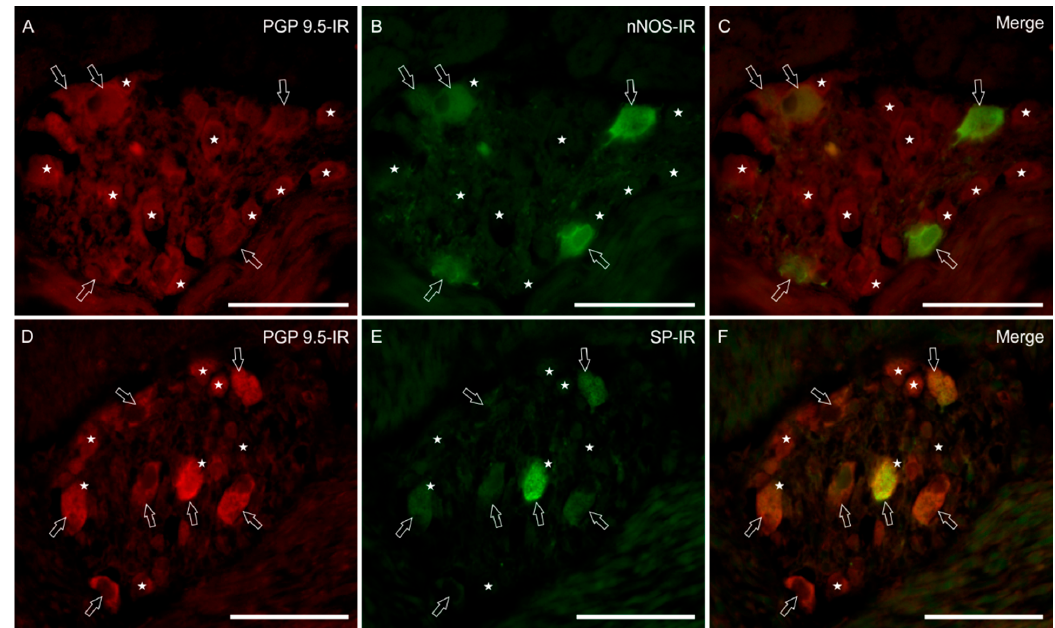
Figure 1. Micrographs showing nNOS ( A – C ) and SP immunoreactivity (IR) ( D – F ) in longitudinal sections of the myenteric plexus in bottlenose dolphin intestine. Stars indicate PGP 9.5 immunoreactive myenteric plexus neurons ( A , D ) which were not immunoreactive for the neuronal nitric oxide synthase (nNOS-IR) and substance P (SP-IR); arrows indicate PGP 9.5 immunoreactive neurons, which were also nNOS-IR ( B ) and SP-IR ( E ). ( C , F ) Merged images. Scale bar: 50 µm.